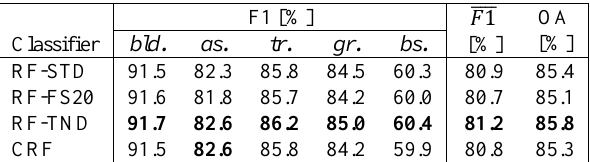
Table 4. Results of land cover classification for different variants of RF (cf. Section 4.1) and the CRF.